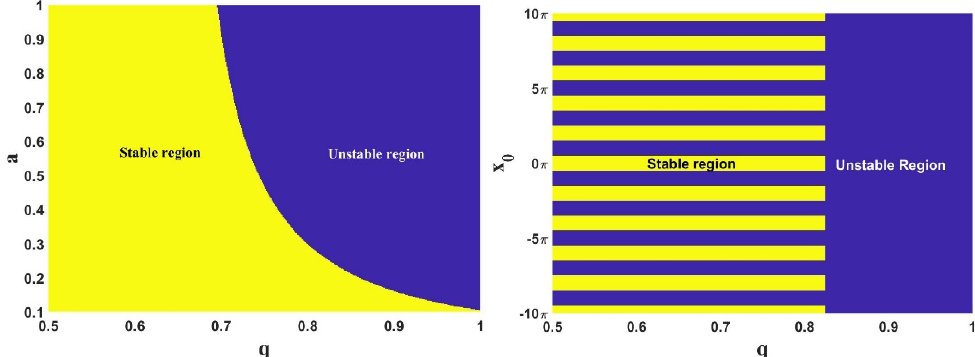
Figure 3. The stability of the equilibrium points of the FJJ oscillator with the left plot showing the stability for q versus and a the right plot for q versus x 0 .